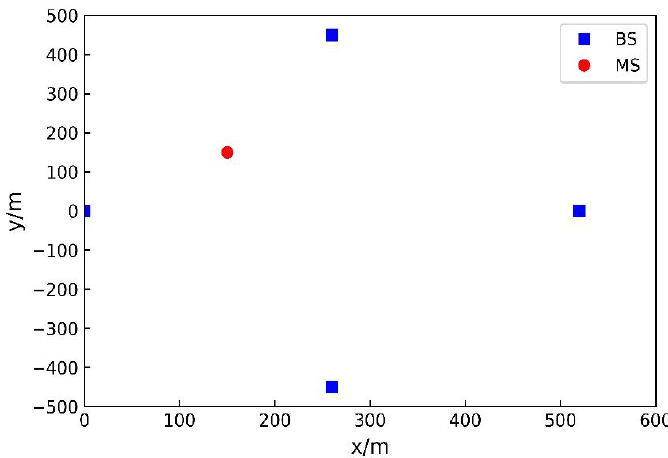
Figure 3. Localization of geometry.